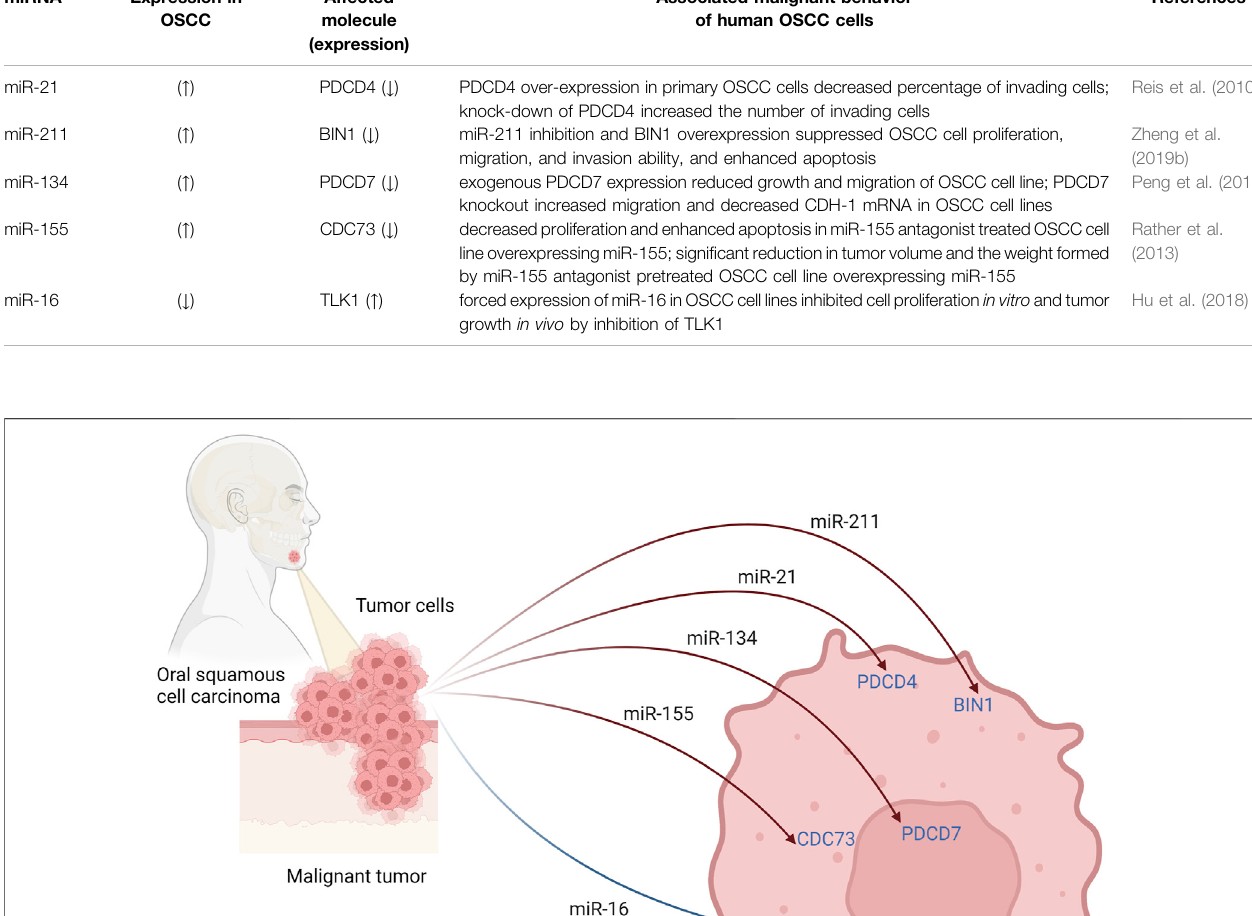
Frontiers in Genetics |